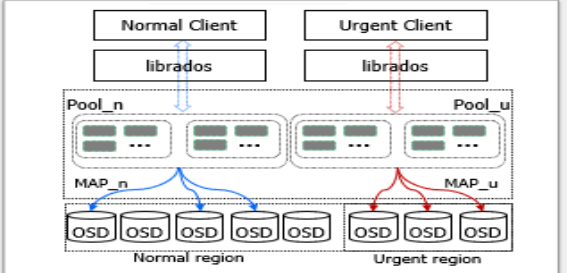
Figure 5. Isolated mode: OSDs are divided into two regions, one for normal clients and the other for urgent